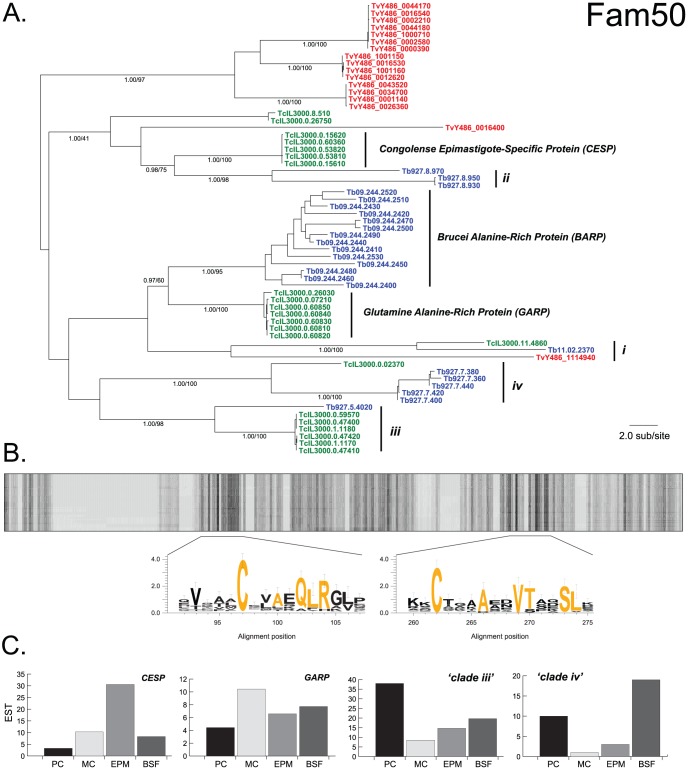
Bayesian phylogeny and expression of BARP/GARP-like genes (Fam50).
A. The phylogram was estimated from a multiple protein sequence alignment of 307 characters. The tree is mid-point rooted. Selected nodes are supported by posterior probability values and non-parametric bootstraps generated from a maximum likelihood analysis using an LG model with rate heterogeneity. B. Cartoon of sequence conservation across the Fam50 protein sequence alignment, darker shading reflects conservation. Two conserved regions are expanded to show sequence motifs in WebLogo v2.8.2. format [106]; ubiquitous residues are shaded red. C. Histograms showing the number of T. congolense EST corresponding to each of four clades in A, (CESP, GARP, subfamily ‘iii’ and subfamily ‘iv’), recovered from four life stages: procyclic (PC), metacyclic (MC), epimastigote (EPM) and bloodstream form (BSF); data from [41].